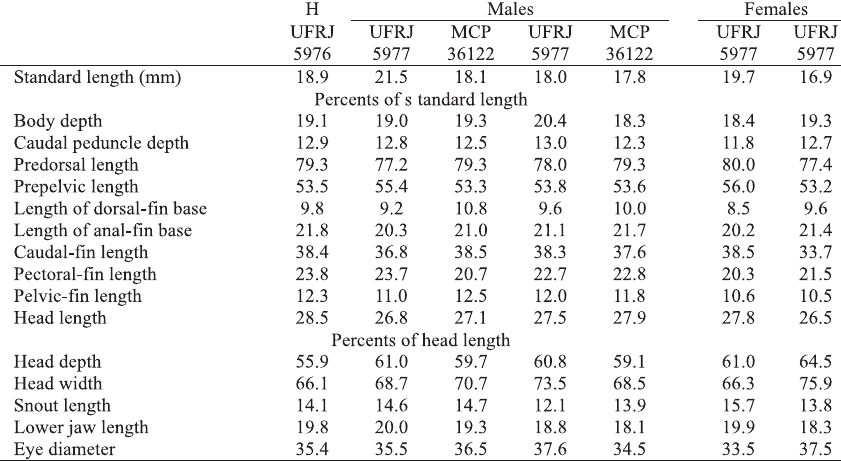
Table 3. Morphometric data of the holotype (H, male) and paratypes of Rivulus rossoi .